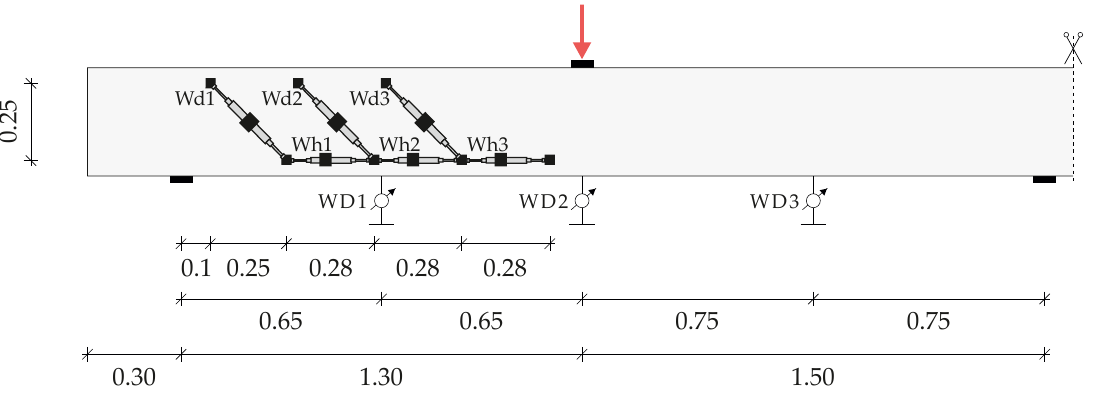
Figure 4. External measuring